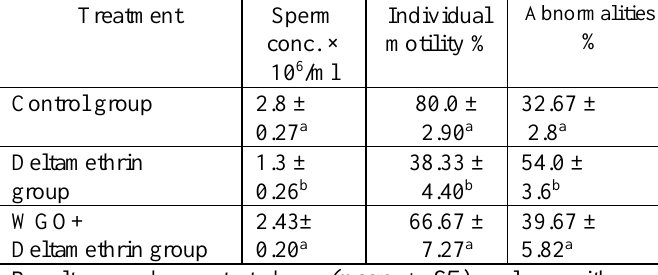
Results are demonstrated as (mean ± SE), values with different superscript letters within the same column; were significantly different ( p ≤ 0.05 ). Table 3: Relative testis weight (g) and serum testosterone level (ng /ml) in controls and treated rats Fig. 2: A : Light microscopy of the control group Relative testicular section clarified that testicular parenchyma Treatment is consisted seminiferous tubules that are closely packed, with organized spermatogenic cells & regular lumen. The minimal Interstitial space was noticed. (H&E stain ×100). B : Light microscopy of the testicular section from the DLM group revealed thick tunica albuginea (black arrow) 3.88 ± 1.03 ab